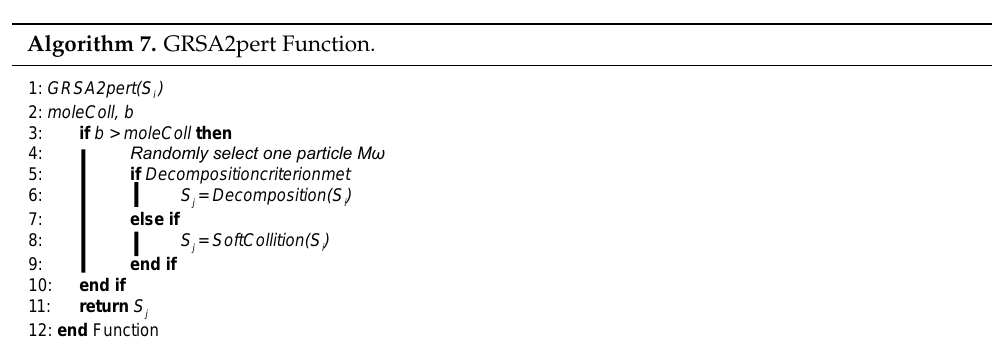
Algorithm 7. GRSA2pert Function.